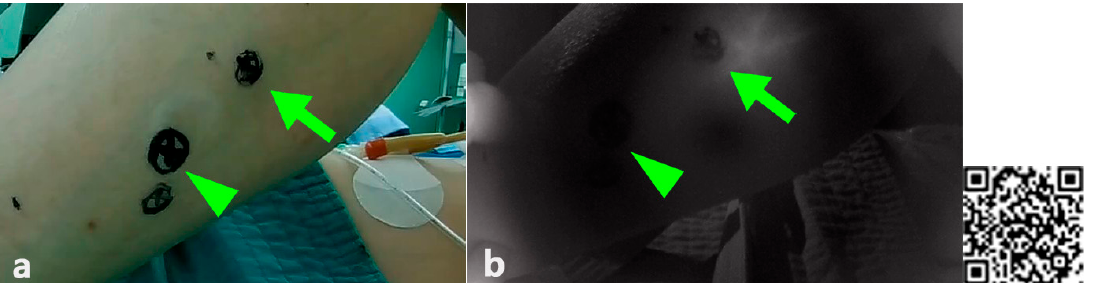
Figure 7. Different outcome in locating perforators between two devices(Doppler and ICG-NIRF prototype). ( a ) Locating perforators with Doppler, ( b ) locating perforators with a DIY ICG-NIR prototype (note that both arrow and arrowhead areas were positive on Doppler signal; however, only the site with the arrow was fluorescent), ( c ) QR code for ICG, free flap, and post-operative flap